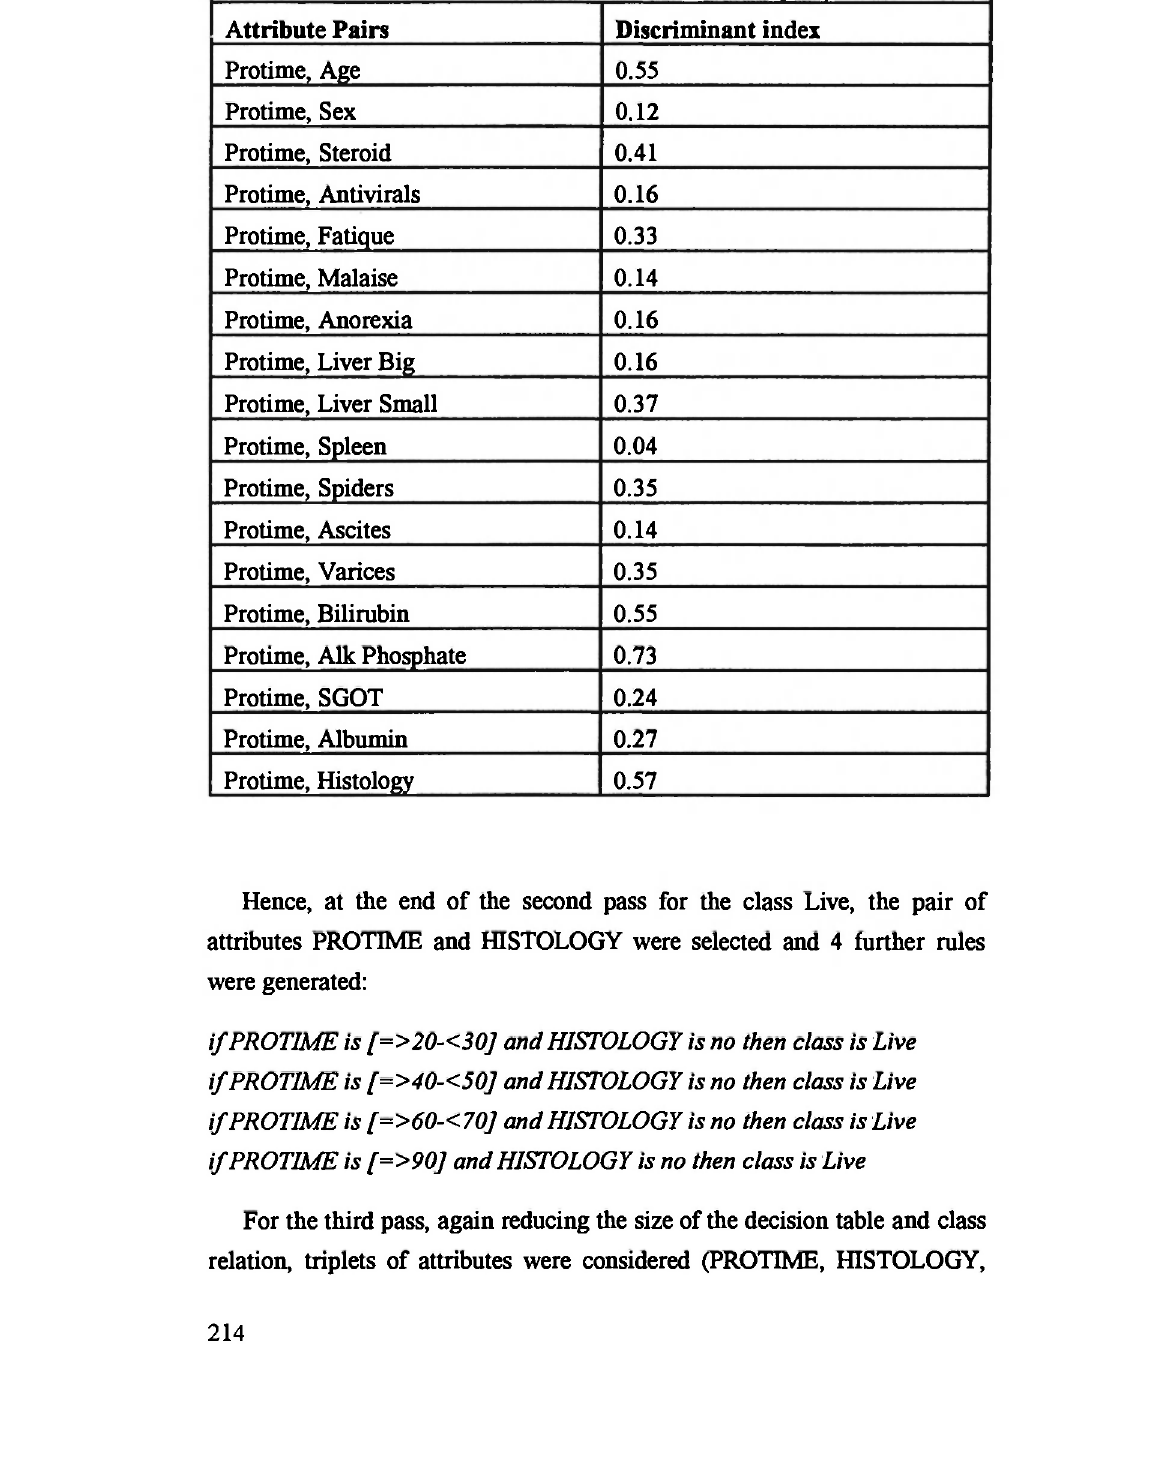
Table 6. Discriminant indices (second